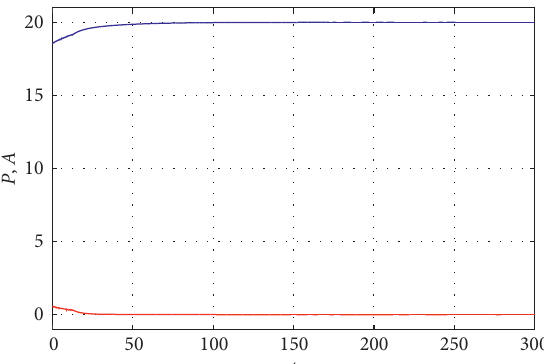
Figure 3: The equilibrium E ∗ of system (4) is stable with τ � 0 . 9.